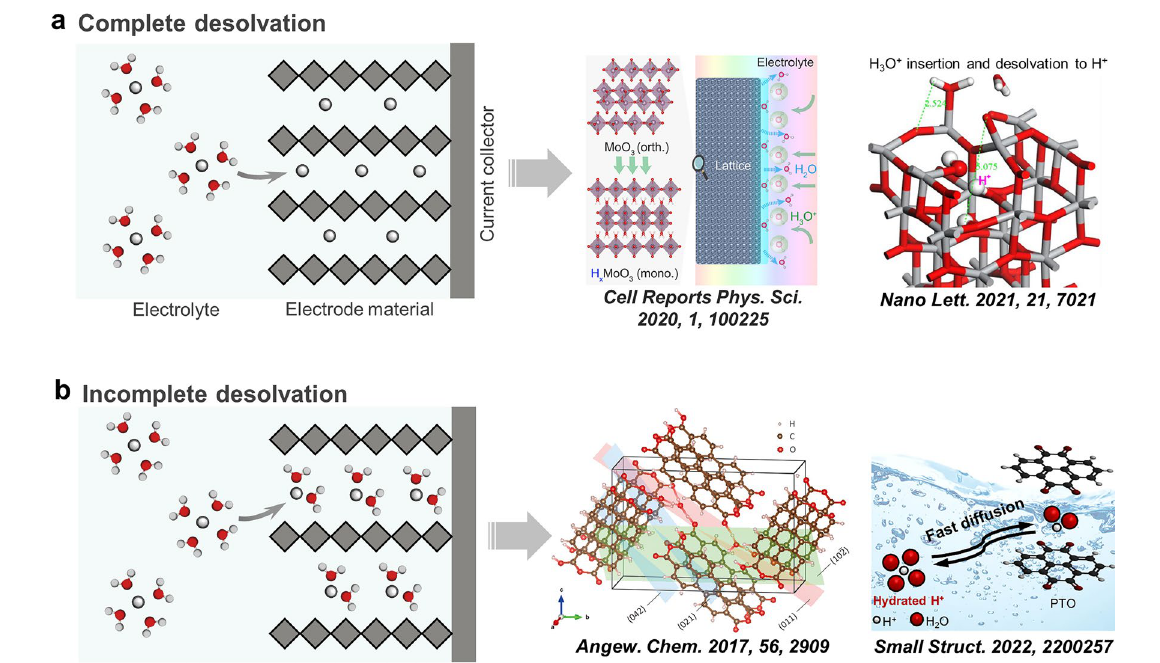
Fig. 2 Illustration of two types of desolvation process at the electrode–electrolyte interface: a complete desolvation and b incomplete desolva- tion